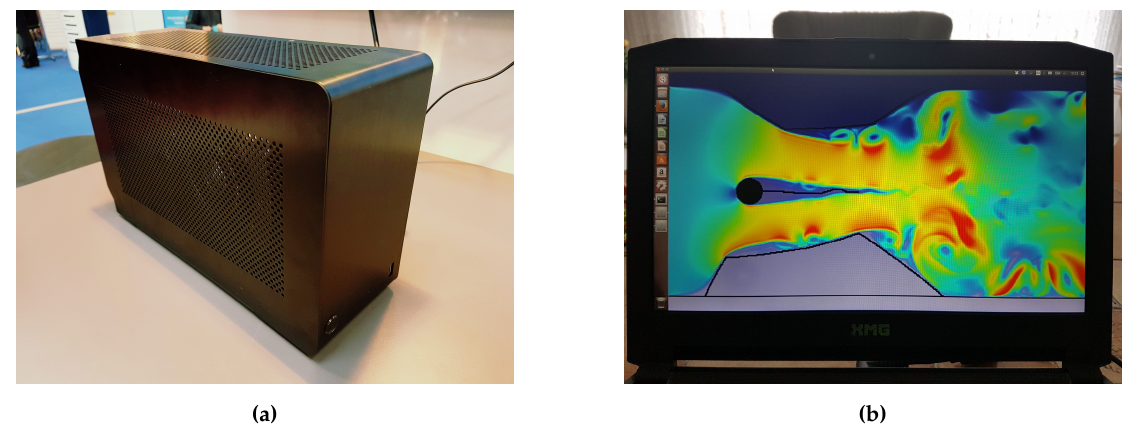
Figure 4. Hardware used for the present work. ( a ) ELBE2go, portable Mini-ITX machine with an NVIDIA GTX Titan GPU, mainly used for lectures, science nights and presentations. ( b ) ELBEbook, gaming notebook with a portable NVIDIA GTX 970M device.